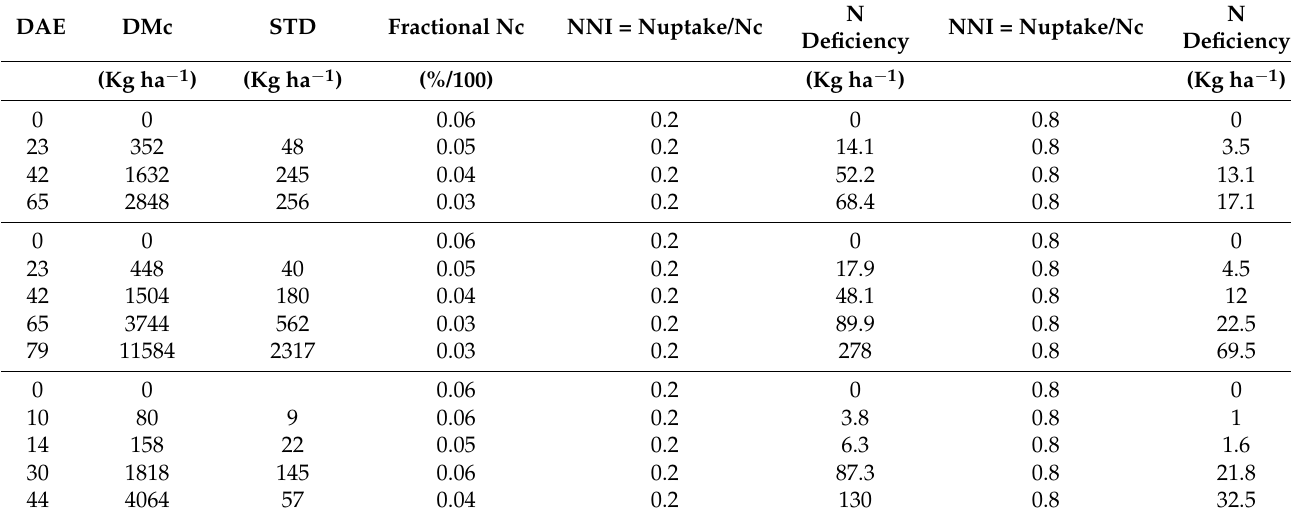
Table 5. Nitrogen deficiency (Kg ha − 1 ) calculated for two values of NNI (0.2 and